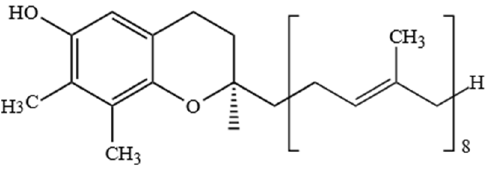
Figure 6. Chemical structure of plastochromanol-8.